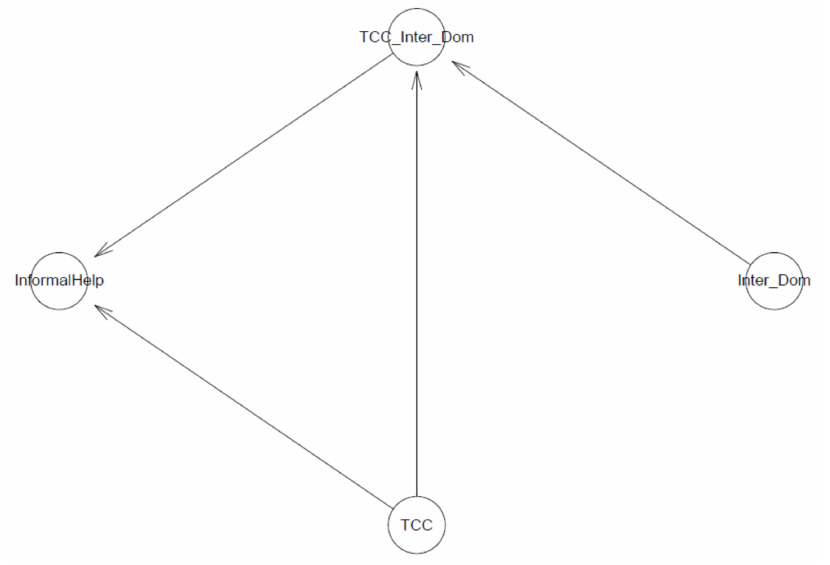
Figure 6. Model 2 (cid:48) s logical network.